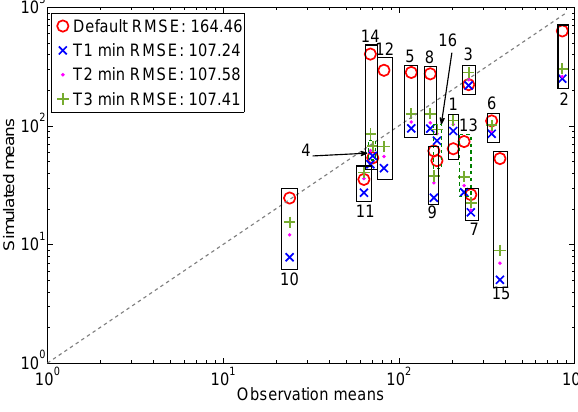
Figure 11. Scatterplot showing the mean values of the CH 4 predic- tions using the default and optimized parameter values of trials T1, T2, and T3, respectively, vs. the mean values of the observations. The numbers in the legend show the best RMSE value correspond- ing to each trial. The numbers above/below the boxes indicate the observation site ID (1: Alberta, 2: Florida, 3: Michigan, 4: